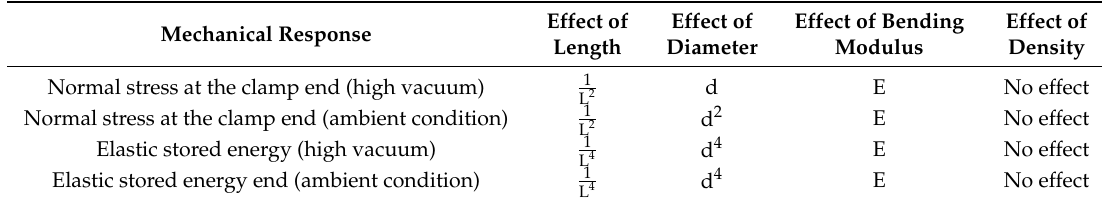
Table 4. The effect of material and geometrical properties of a vibrating nanoresonator in vacuum on its mechanical